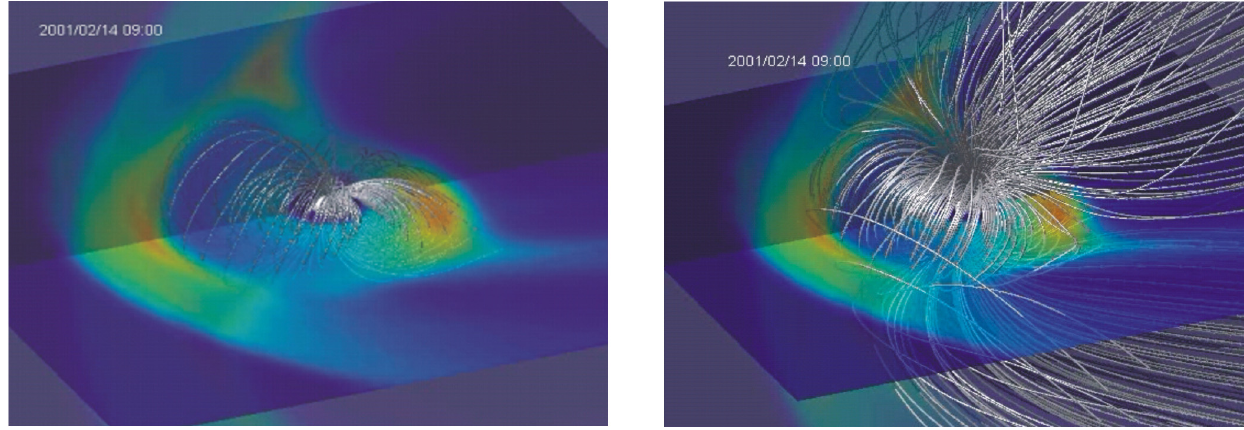
Fig. 2. 3-D representation of the magnetic field lines in a BATS-R-US run at the CCMC; (a) the shading represents the normalised thermal pressure in the ( x , y )-, and ( x , z )-planes, the thick solid lines are magnetic field lines traced with the VisAn MHD plot3DBtubes function; the plot shows the thickness of the magnetosheath between the inner magnetopause boundary and the inner bow shock region; (b) shows the complete representation of the field inside the magnetosphere.